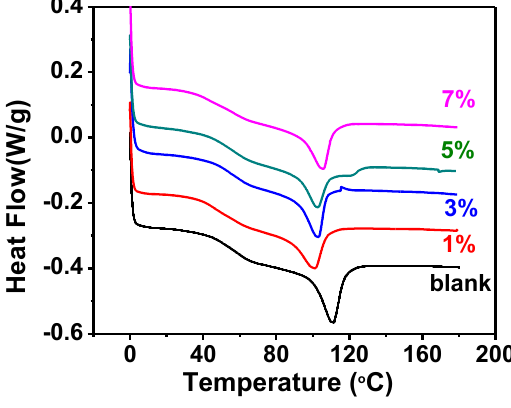
Table 1. Thermal data of xLCNs/SiO